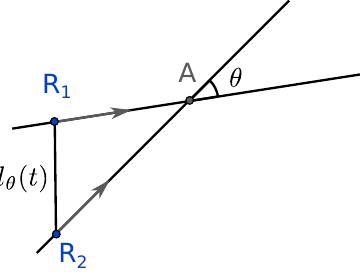
Figure 1. Two robots, R 1 and R 2 , are moving in straight lines toward a target at A. The angle between their trajectory is θ . The distance between the two robots over time is denoted by l θ ( t